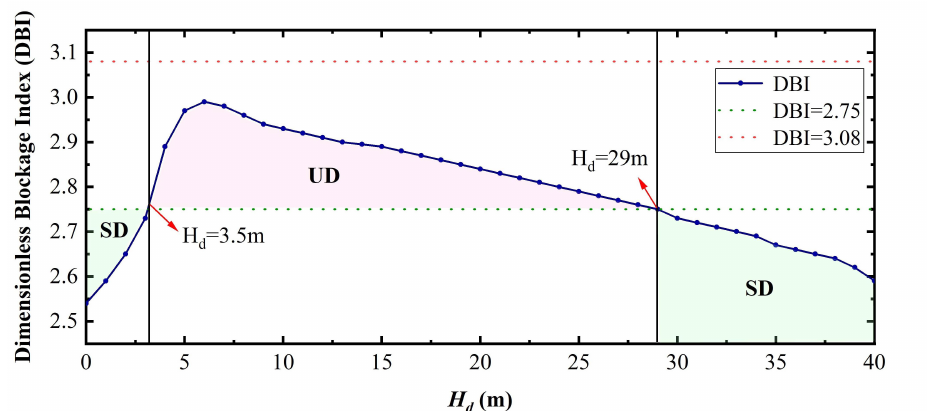
Figure 10. The dimensionless blockage index (DBI) diagram of landslide QLDT01. When the landslide dam is at the height of 3.5 to 29 m, the mean value of DBI is 2.87, which is in the uncertain domain (UD). When the height of landslide dam is lower than 3.5 m and higher than 29 m, the average DBI is 2.66, which is in the stable domain (SD).